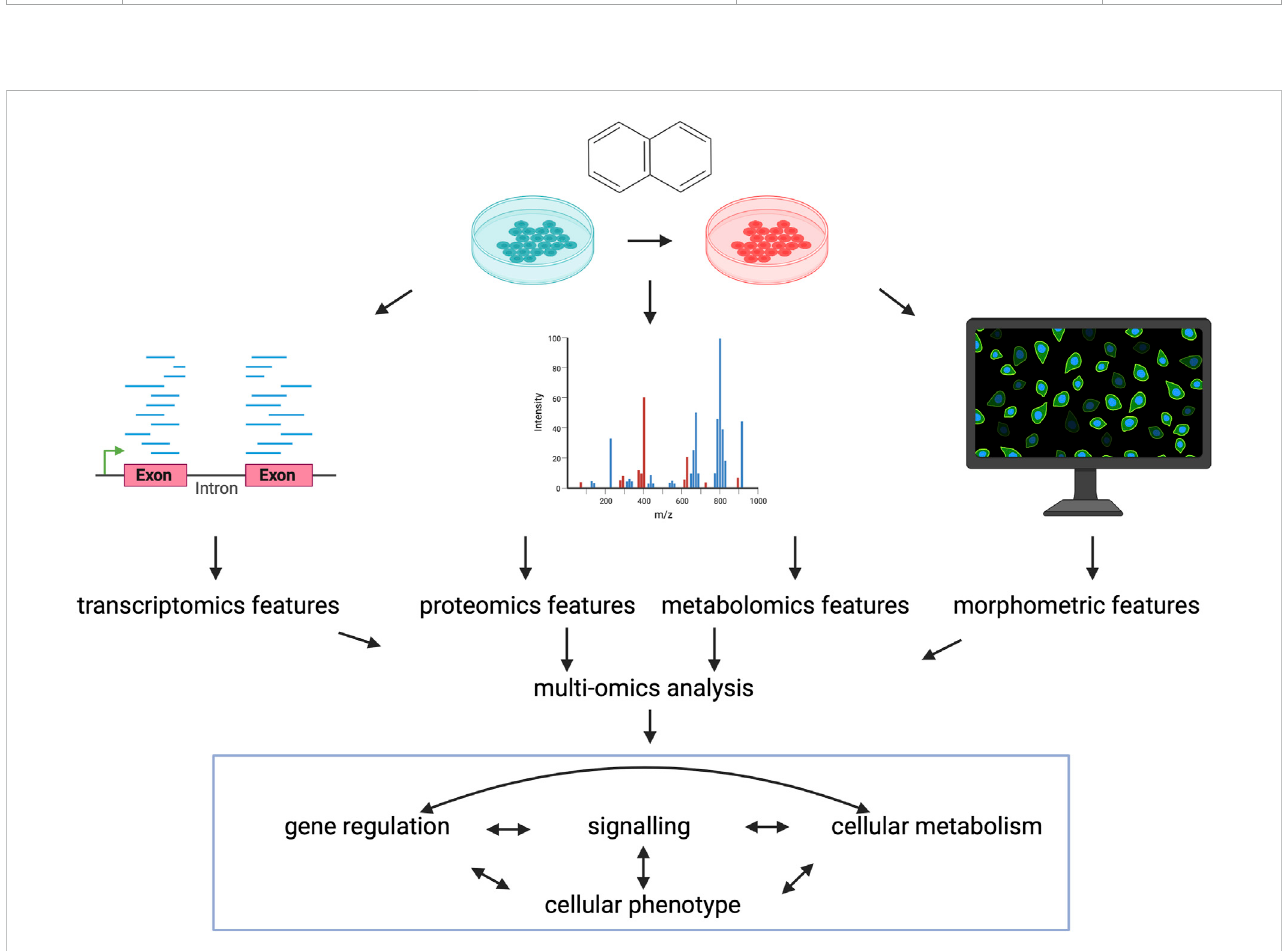
FIGURE 4 Perturbation multi-omics. Characterising the same perturbations with data from different omics-modalites can give better description of cellular phenotype and can better describe the individual layers of cellular regulation and the connections between them. Created with BioRender.com.